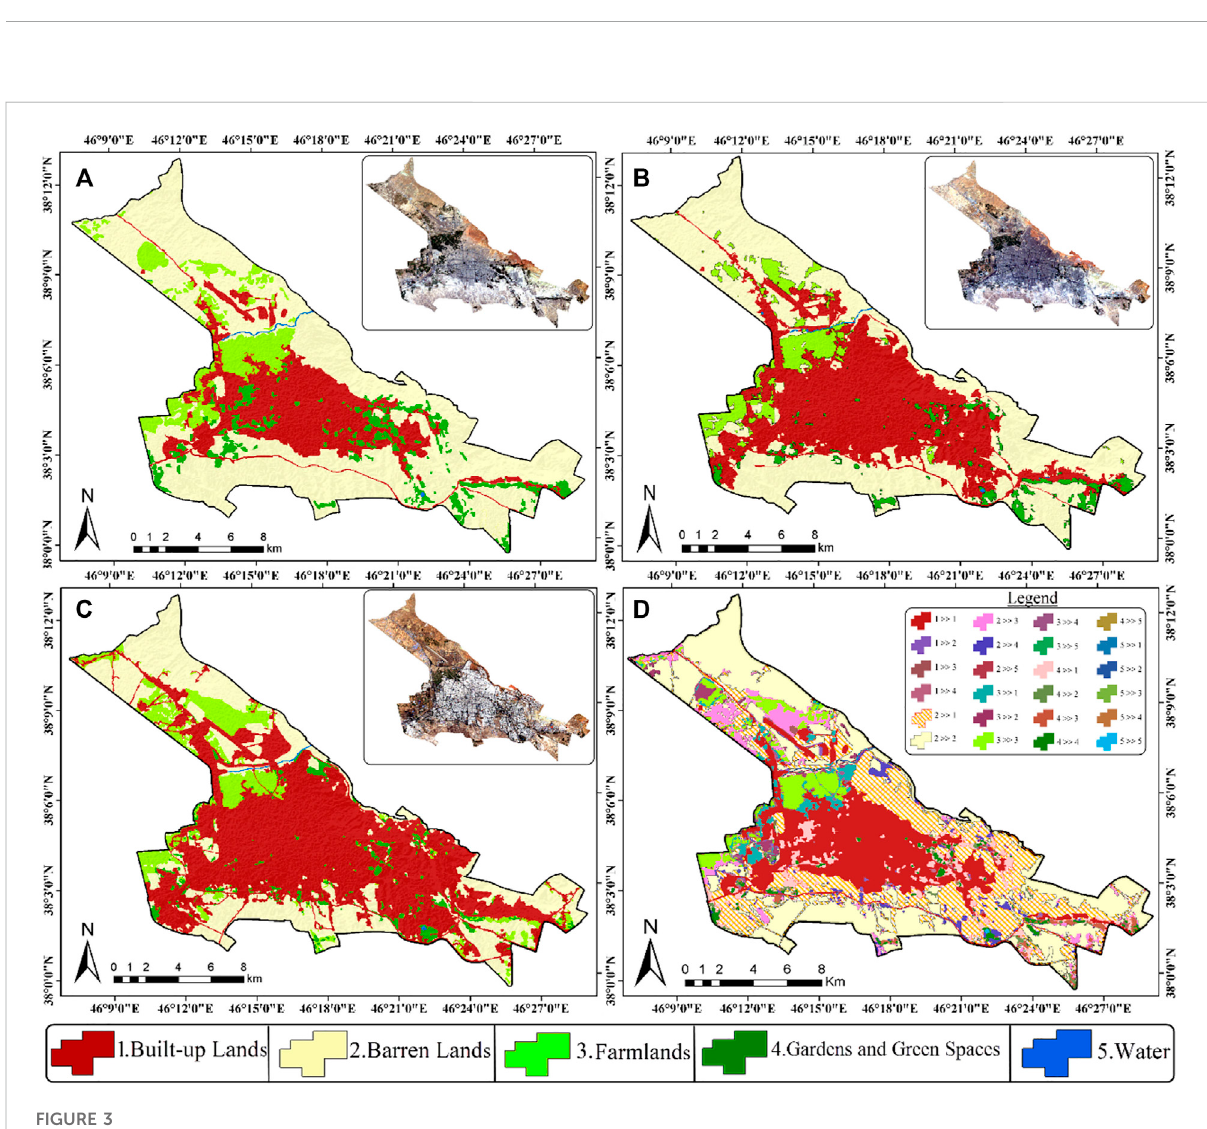
Frontiers in Environmental